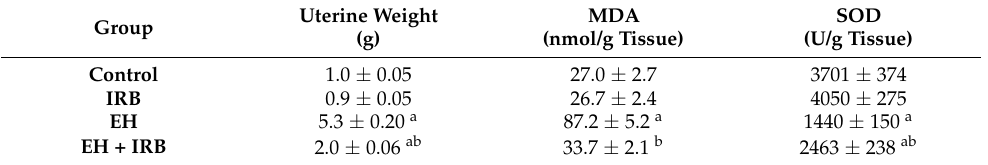
Table 1. Effect of irbesartan (IRB) on uterine weights, malondialdehyde (MDA), and superoxide dismutase (SOD) in estradiol benzoate-induced endometrial hyperplasia (EH) and atypia in rats. Group